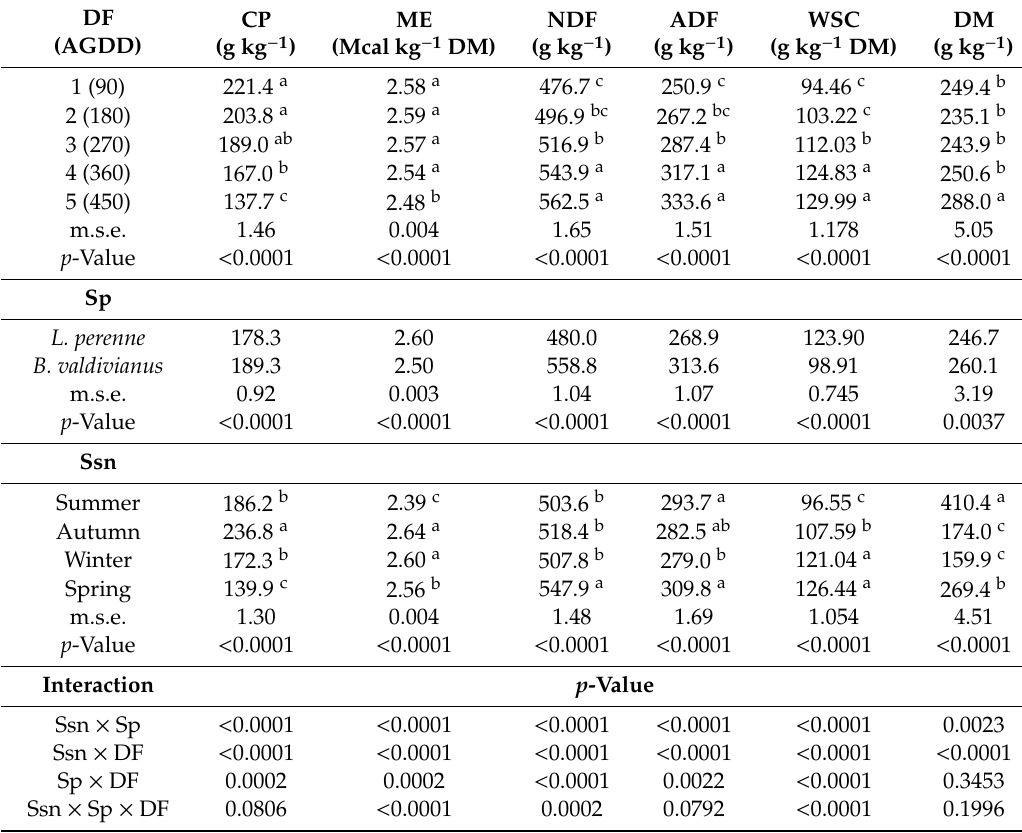
Table 2. Nutritive value of two species ( Lolium perenne L. and Bromus valdivianus Phil.) at five defoliation frequencies across